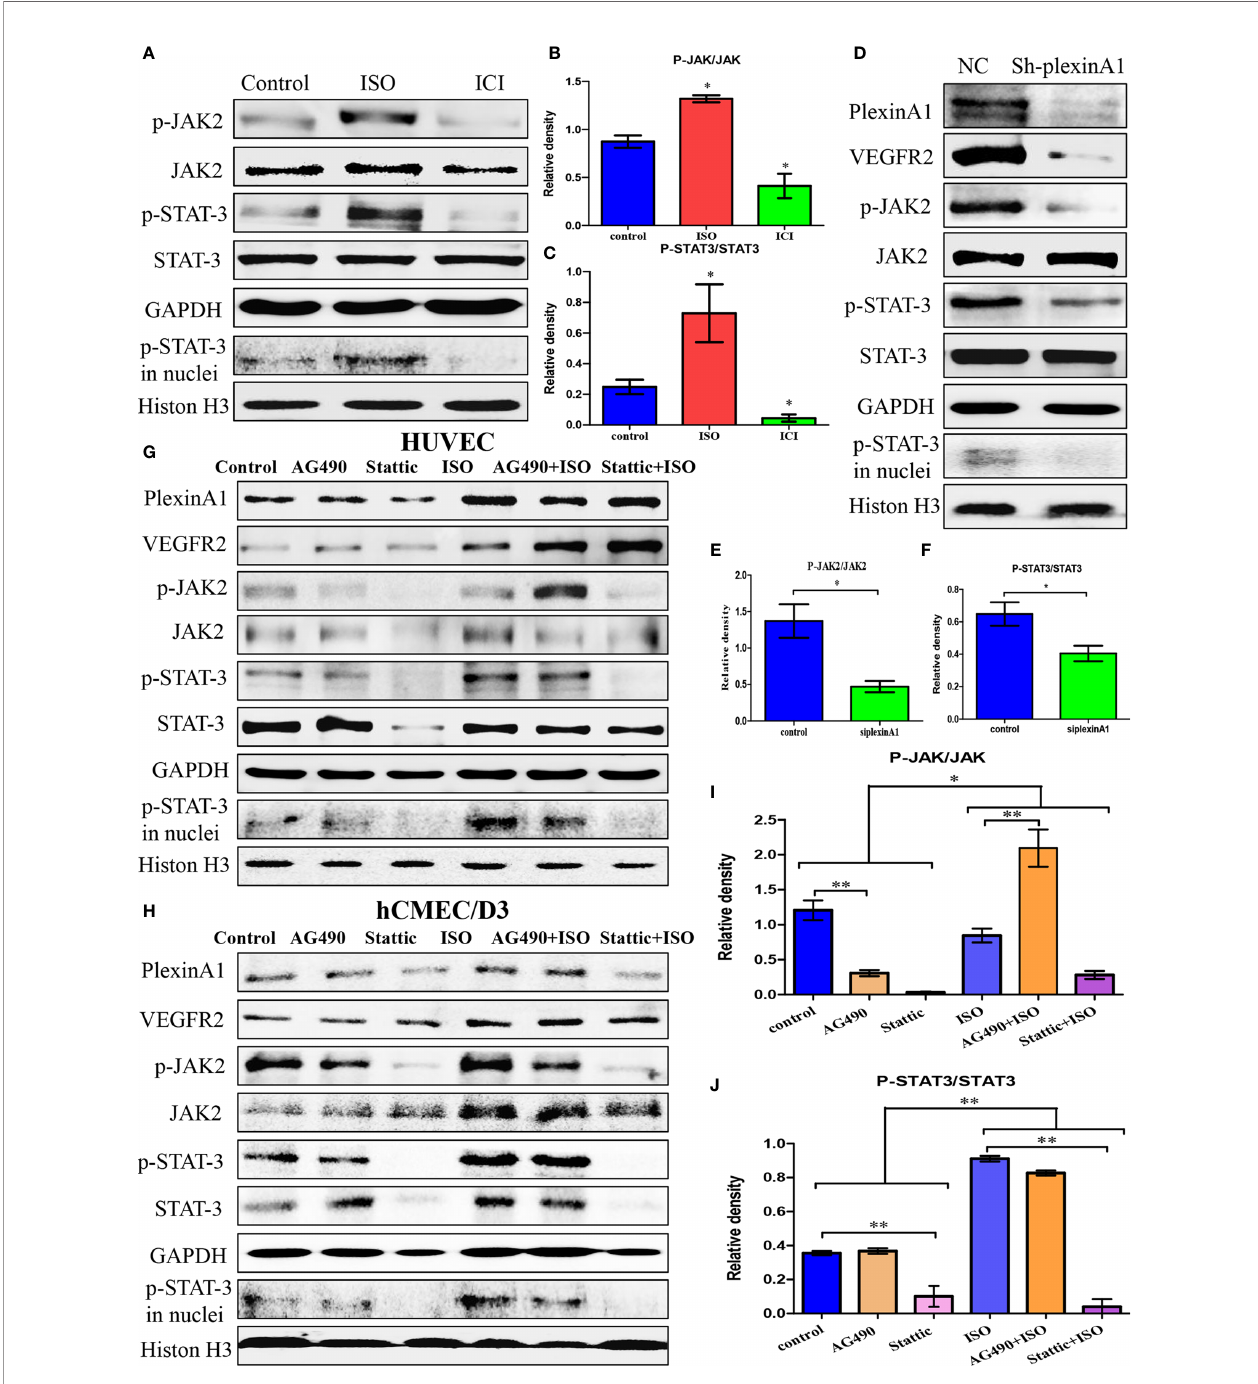
FIGURE 4 | Isoprenaline promotes plexinA1/VEGFR2 expression via JAK2-STAT3 pathway. (C) HUVECs were treated with ISO or ICI. (A) The protein levels of JAK2/STAT3 were analyzed. The effect of isoprenaline on p-JAK2/JAK2 (B) and p-STAT3/STAT3 (C) expression. (D – F) HUVECs were classi fi ed as NC and ShplexinA1 group. (D) PlexinA1, VEGFR2 and JAK2/STAT3 at protein levels were evaluated by western blots. The effect of ShplexinA1 on p-JAK2/JAK2 (E) and p- STAT3/STAT3 (F) expression. (G – J) : HUVECs and hCMEC/D3 were treated with AG-490 or stattic, and then incubated in the medium containing 0, 10uM isoprenaline for additional 12h. (G) PlexinA1, VEGFR2 and JAK2/STAT3 at protein levels in HUVECs were evaluated by western blots. (H) PlexinA1, VEGFR2 and JAK2/STAT3 at protein levels in hCMEC/D3 were evaluated by western blots. The effect of JAK2-STAT3 pathway inhibitors and isoprenaline on p-JAK2/JAK2 (I) and p-STAT3/STAT3 (J) expression. Data are expressed as mean ± SD (n = 3, *P < 0.05, **P <